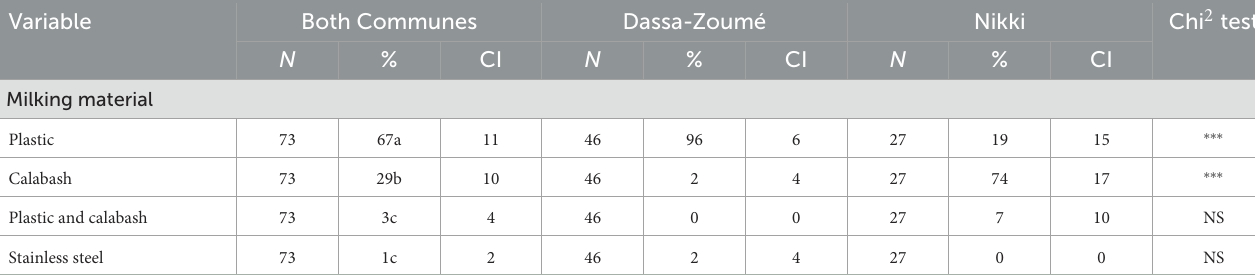
TABLE 5 Types of equipment used for milking and curd production.